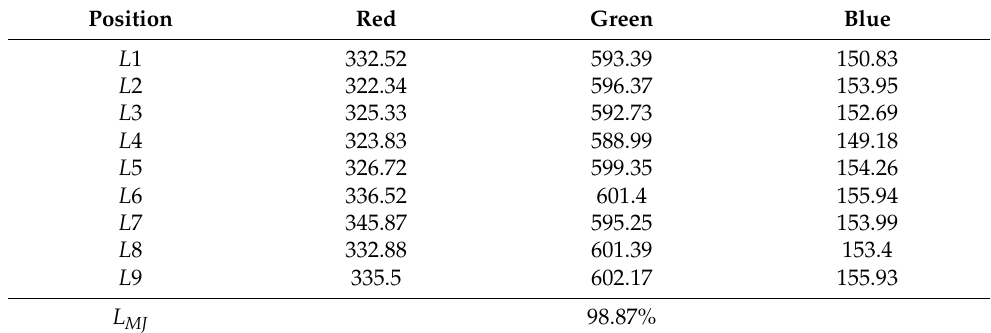
Table 1. The brightness of the display module with the same viewing angle selected by this experi- mental method (cd/m 2 ).